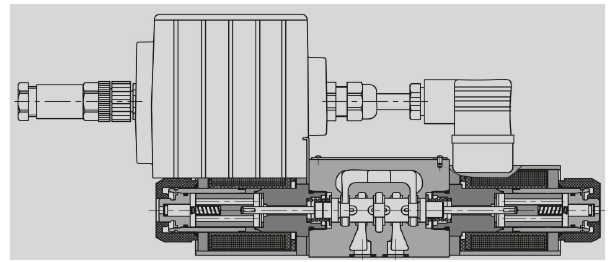
Figure 1: Structure of electromagnetic proportional directional control valve.